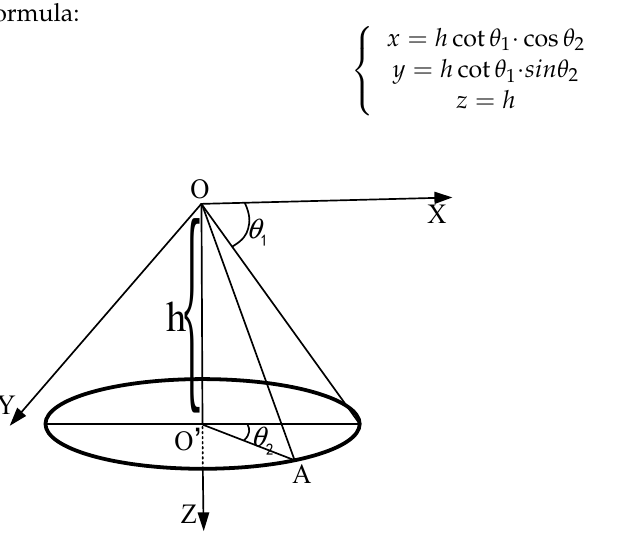
Figure 9. Coordinate transformation model.